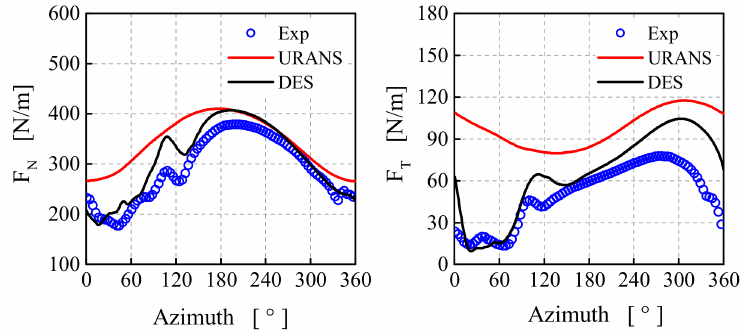
Figure 15. Normal and tangential forces variations at 35% span at 24 m/s wind